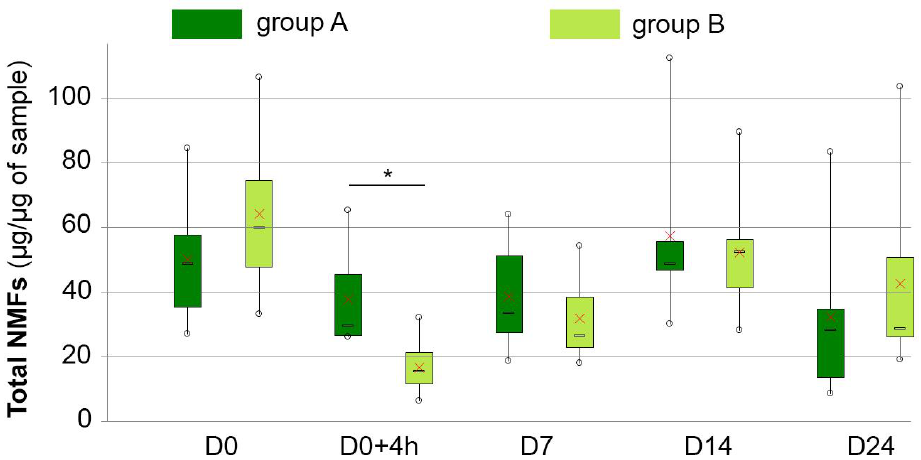
Figure 2. Kinetics of natural moisturizing factors (NMFs) in dogs with keratinization disorders that were washed in plain water (group A — dark green boxes) or received DOUXO ® S3 SEB shampoo and mousse (Ceva Santé Animale, France) (group B — light green boxes) at different time points during the study. Interpretation of the box and whisker plots: lower and upper box boundaries 25th and 75th percentiles, respectively, line inside box median, lower and upper whiskers minimum and maximum scores, respectively. X represents the mean. * represents significant differences at p = 0.05, compared to baseline